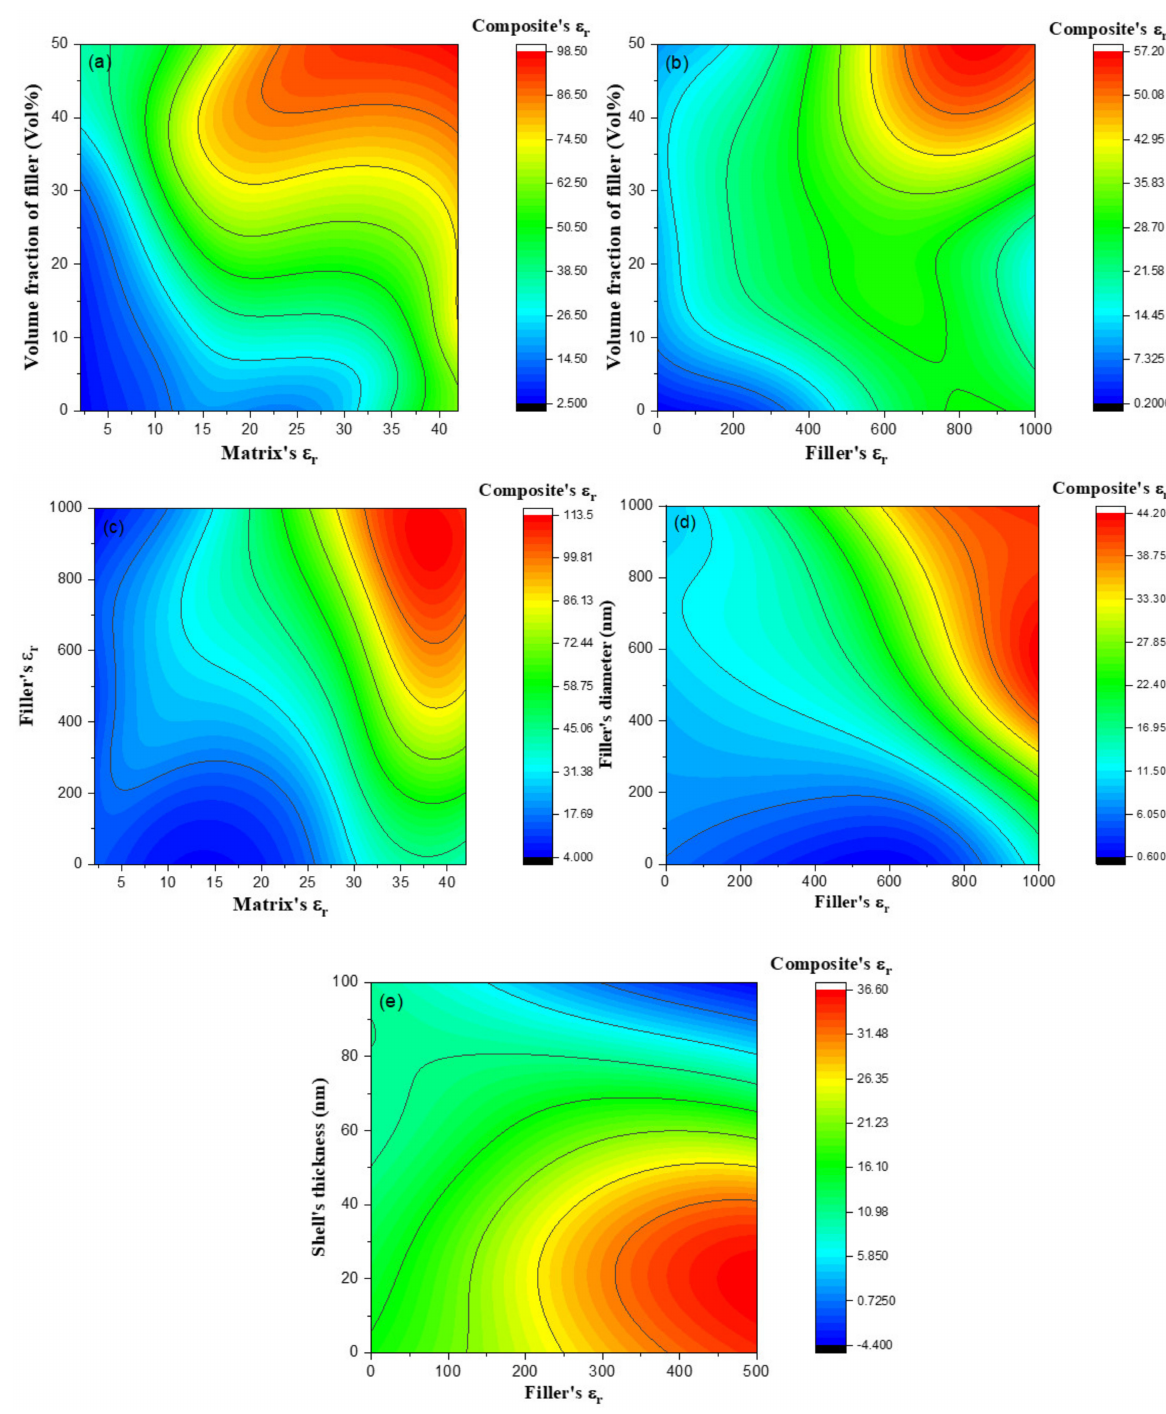
Figure 7. 2D contour plots showing combined effect of ( a ) matrix’s dielectric constant, ( b ) filler’s dielectric constant and filler’s volume fraction, ( c ) matrix and filler’s dielectric constant, ( d ) filler’s diameter, ( e ) shell’s thickness and filler’s dielectric